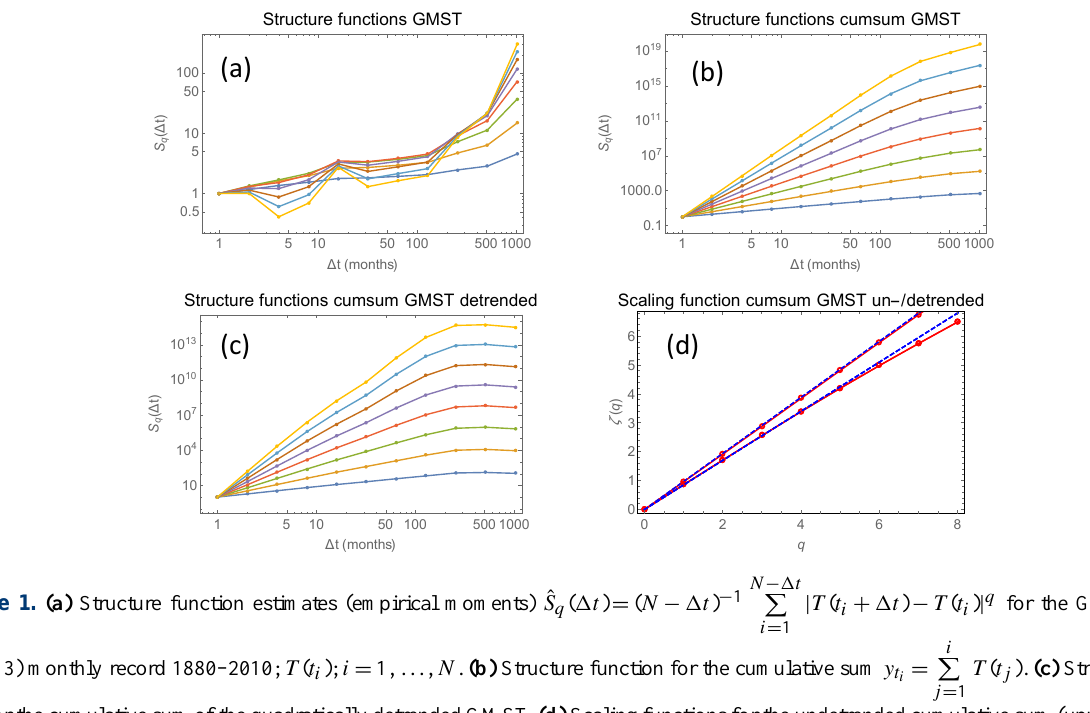
Figure 1. (a) Structure function estimates (empirical moments) ˆ S q ( (cid:49)t ) = ( N − (cid:49)t ) − 1 CRUT3) monthly record 1880–2010; T ( t i ); i = 1, ..., N . (b) Structure function for the cumulative sum y t tion for the cumulative sum of the quadratically detrended GMST. (d) Scaling functions for the undetrended cumulative sum (upper line) and the detrended cumulative sum (lower